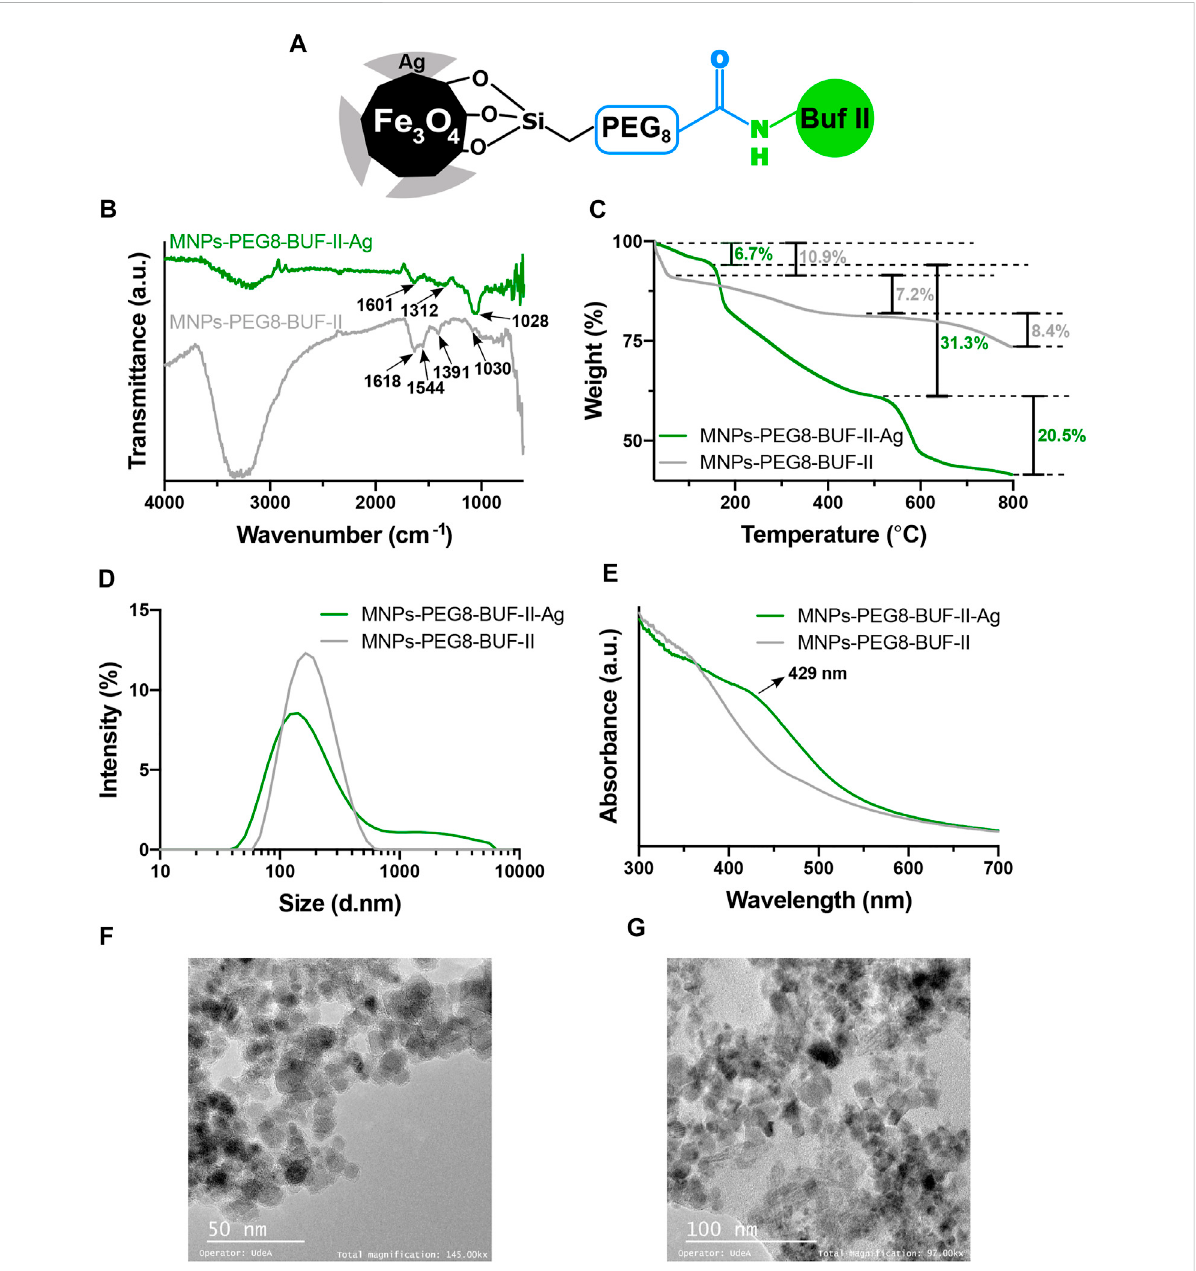
FIGURE 1 Characterization of MNPs-PEG8-BUF-II-Ag nanobioconjugates. (A) Schematic of the nanobioconjugate after the synthesis. (B) and (C) correspondtotheFTIRandTGAanalysis,respectively. (D) Meanhydrodynamicdiameterofthenanobioconjugates via DLS. (E) UV-VISanalysisofthe nanobioconjugate before and after the Ag core-shell growth. The morphology and size of the MNPs- PEG8-BUF-II-Ag nanobioconjugates were analyzed through TEM at two different magni fi cations: (F) 145 kX and (G) 97